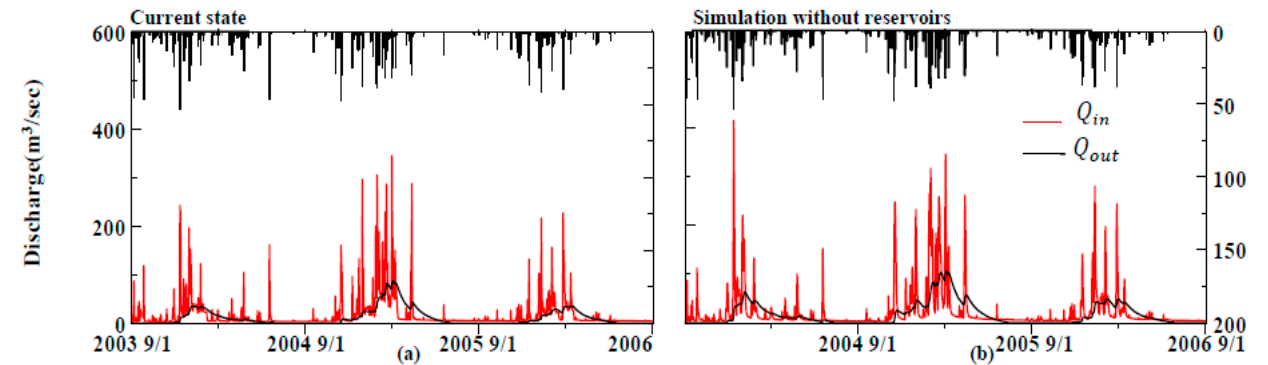
Figure 16. The simulations of the total inflow to, and outflow from, the lake: ( a ) the simulation of the current state ( b ) the simulation without the reservoirs.